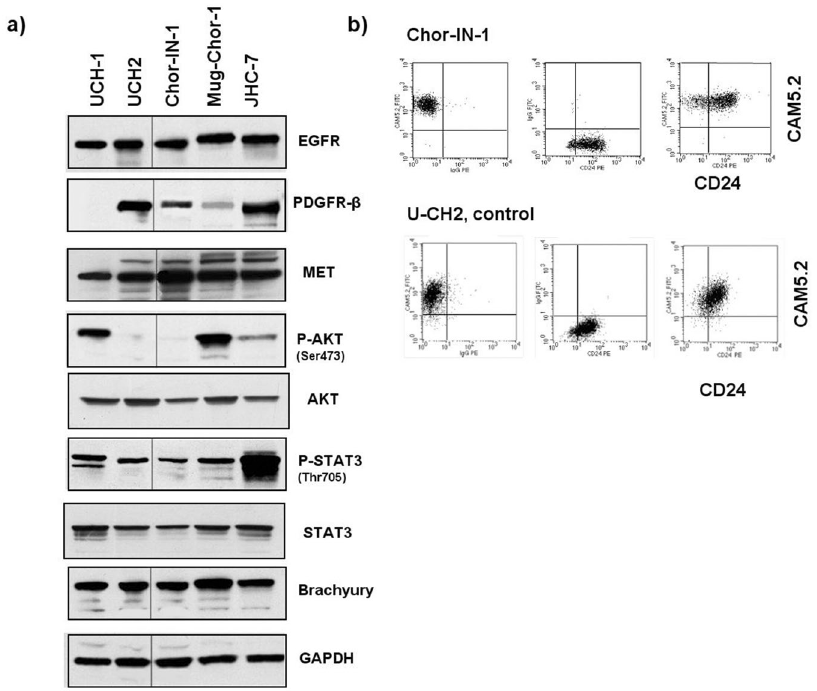
Figure 2. Molecular Characterization of Chor-IN-1 cell line. ( a ) Immunoblot analysis of key tyrosine kinase receptors and other signaling molecules: Chor-IN-1, in parallel with U-CH1, U-CH2, MUG-Chor1 and JHC7 cells were seeded as indicated and collected at 70% confluence. Protein cell extracts were resolved by SDS-PAGE and filters probed with the indicated antibodies. Full-length blots are presented in Supplementary Figure 6. ( b ) Flow Cytometry analysis of chordoma typical membrane proteins: the expression of CD24 and CAM5.2 membrane antigens in Chor-IN-1 was confirmed to be comparable to that of the U-CH2 cell line used as reference. Upper cytograms refer to Chor-IN-1 cells and lower cytograms refer to UCH-2 cells. Left = FITC CAM5.2 vs . PE isotype ctrl: 100% of both cell lines express the marker, in the absence of non-specific signals. Middle = PE-CD24 vs . FITC isotype ctrl: more than 90% of both cell lines express the marker, in the absence of non-specific signals. Right = FITC CAM5.2 vs . PE-CD24: both cell lines are more than 90% CD24/CAM5.2 double positive, confirming both markers are expressed at levels comparable to that of UCH-2 reference cell